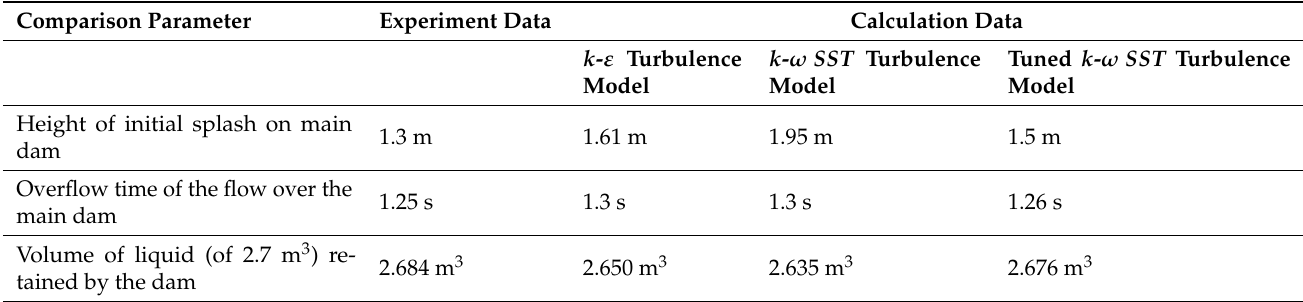
Table 5. Comparison of measured and calculated flow parameters in the presence of three dams.